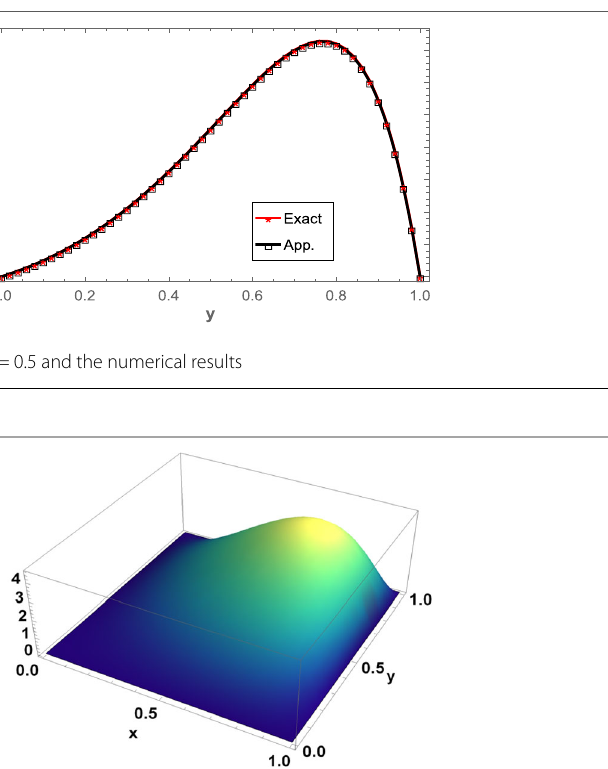
Figure 3 Three-dimensional graph for numerical